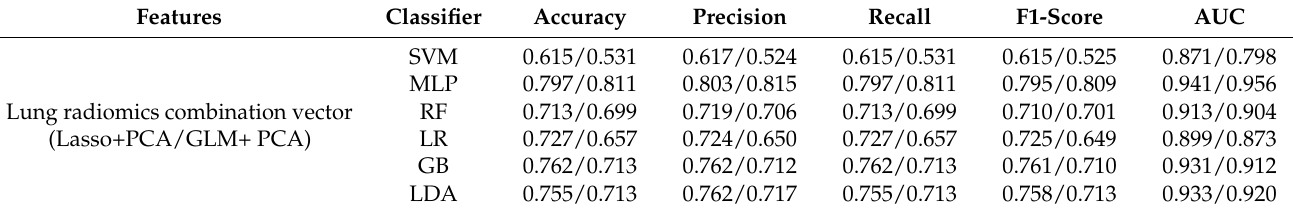
Table 7. The different ML classifiers’ performance on the test set of lung radiomics combination vector (Lasso + PCA/GLM + PCA) in Experiment